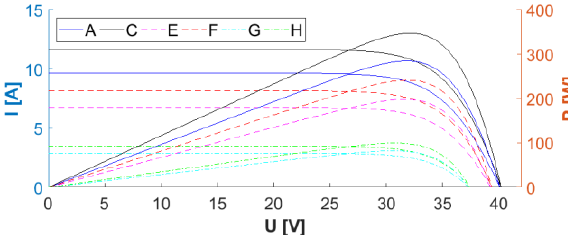
Fig. 3. Current-voltage characteristics and power characteristics of the LG300N1T-G4 bifacial panel for different BGE and E